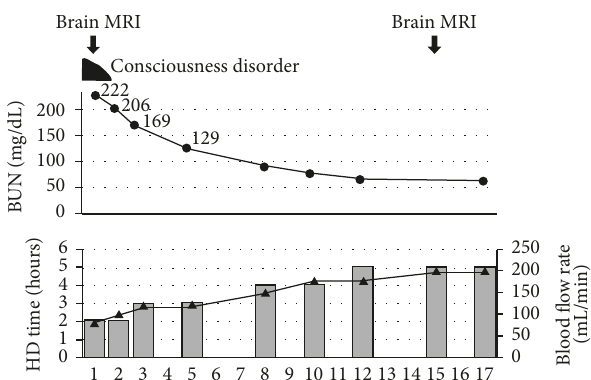
Figure 3: Clinical course during patient’s initiation period. HD, hemodialysis; BUN, blood urea nitrogen; MRI, magnetic resonance imaging. Columns show changes in HD duration. Closed triangles show changes in HD blood flow